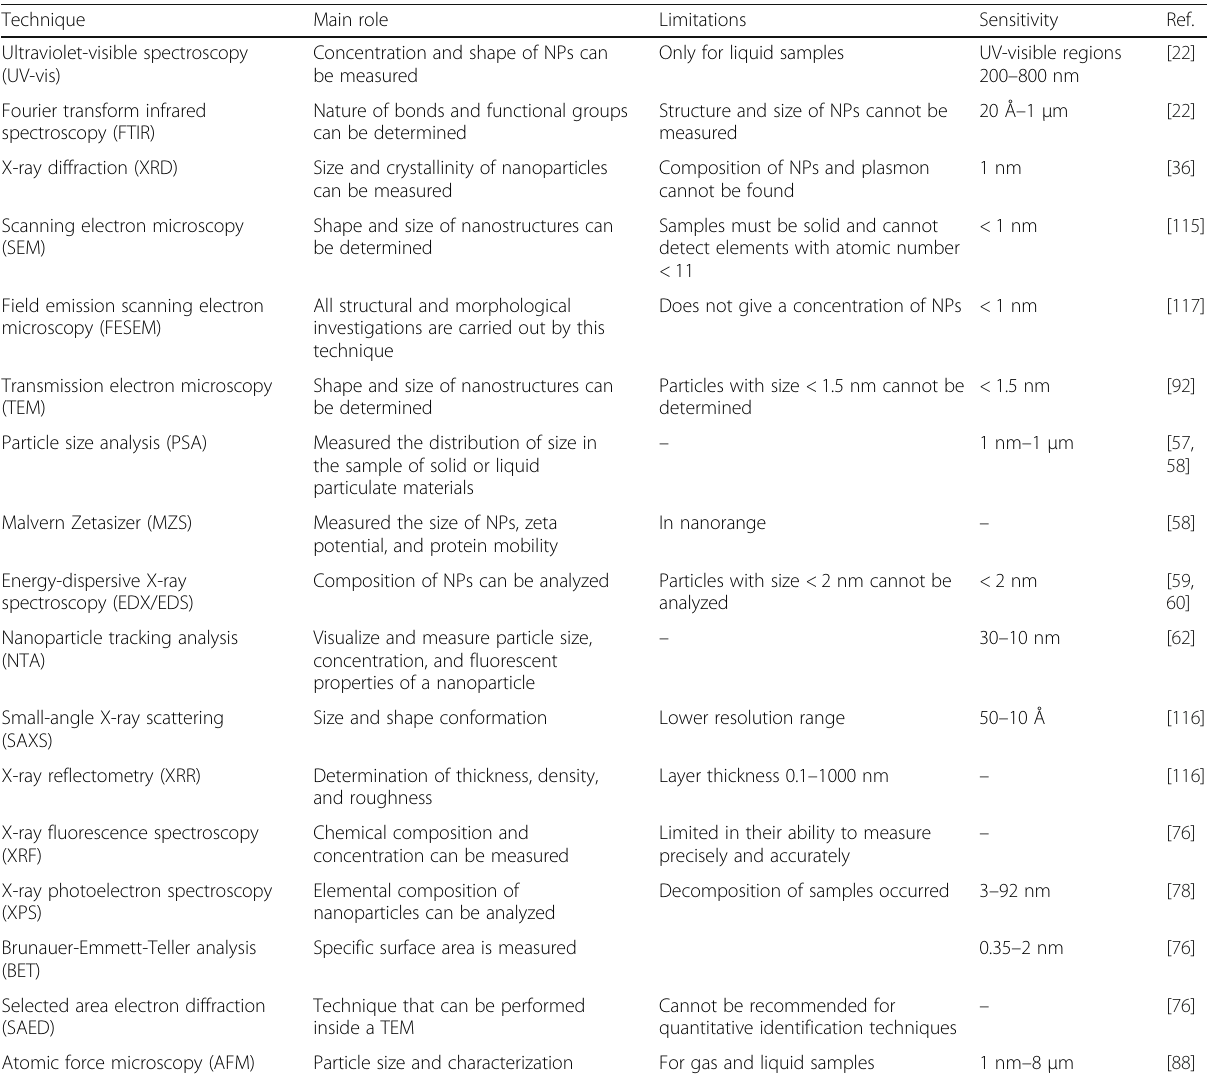
Table 3 Characterization techniques and